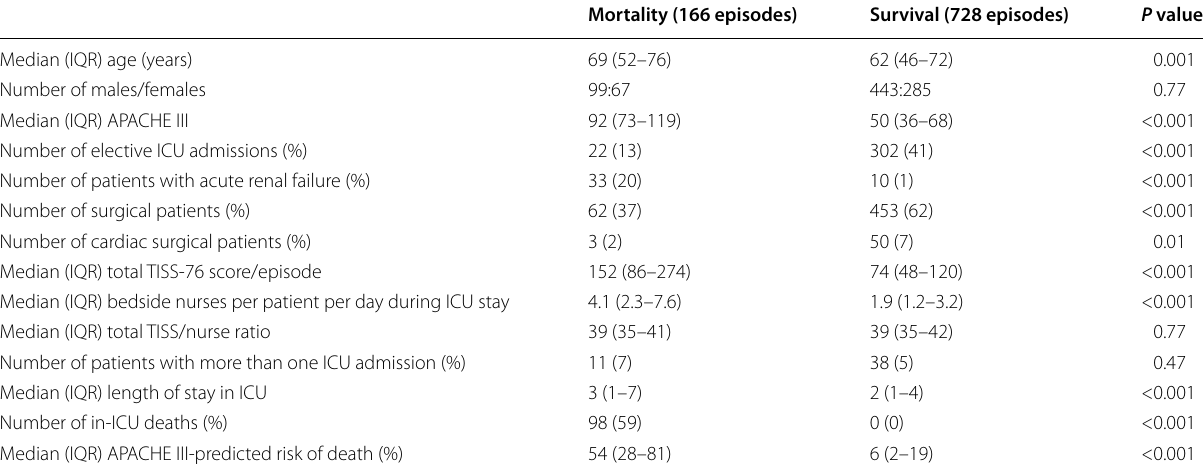
IQR interquartile range, APACHE III Acute Physiology and Chronic Health Evaluation III, TISS-76 76 item Therapeutic Intervention Scoring System